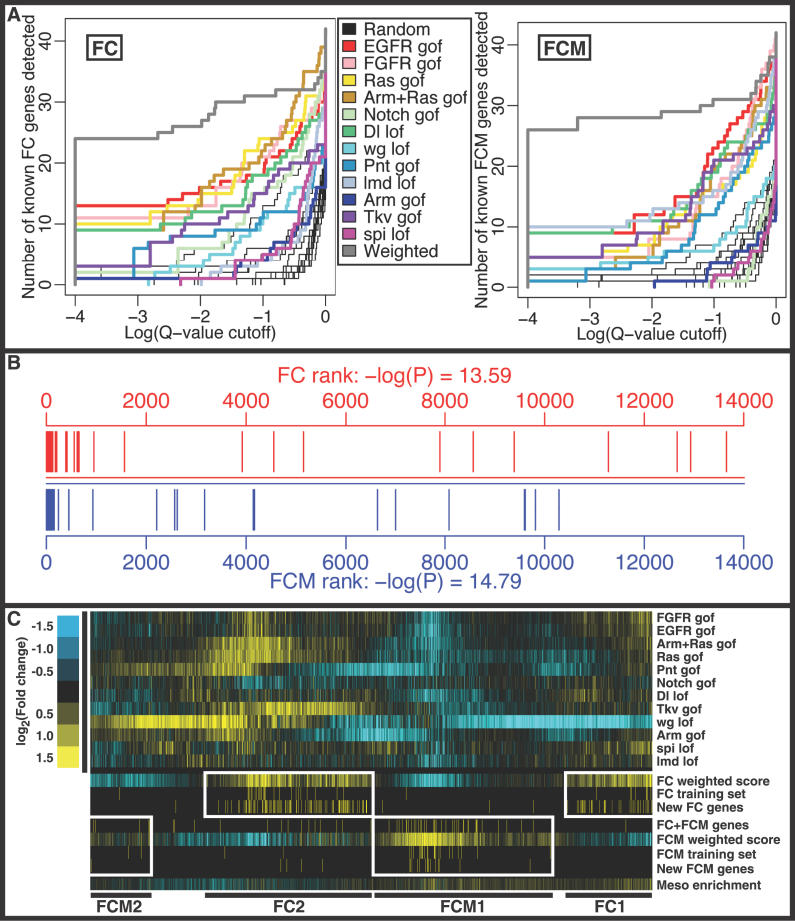
Statistical Meta-Analysis of an Expression Profiling Compendium for Predicting Myoblast-Specific Genes(A) Detection curves showing the number of probe sets from the training set detected, as a function of q-value, for FC genes (left) and FCM genes (right). In each panel, the predictive value of individual genotype/wild-type comparisons (various colors; see legend) are compared to randomly generated rankings (thin black lines) and to composite rankings derived from a weighted combination of all datasets (gray). To avoid introducing biases for or against any genotype, the training sets were composed of known genes from the literature as well as the mesodermally enriched genes that had been verified by in situ hybridization in this study to be FC or FCM genes, for a total of 43 FC probe sets and 42 FCM probe sets (Table S2).(B) All probe sets on the chip were ranked according to their degree of FC-like (red axis) or FCM-like (blue axis) expression pattern, using their weighted T-scores. The ranks of the training set probe sets (FC in red, FCM in blue) within their respective axes are plotted as thin vertical lines, revealing the extent to which optimization concentrates each training set at the top of its corresponding rank. P values shown are from the Wilcoxon-Mann-Whitney U test. Thick lines reflect the merging of individual thin vertical lines.(C) Clustering of genotype data (first 12 rows) by self-organizing maps produces two clusters enriched for known and predicted FC genes (FC1 and FC2, white boxes) and two clusters enriched for known and predicted FCM genes (FCM1 and FCM2, white boxes). For reference, FC- and FCM-weighted T-scores are depicted (yellow: T > 0, blue: T < 0, and saturated yellow/blue colors correspond to the 98% percentile of the absolute T-values). Also highlighted are the locations of validated FC and FCM genes (yellow lines), as well as mesodermal fold change levels (“meso enrich”).